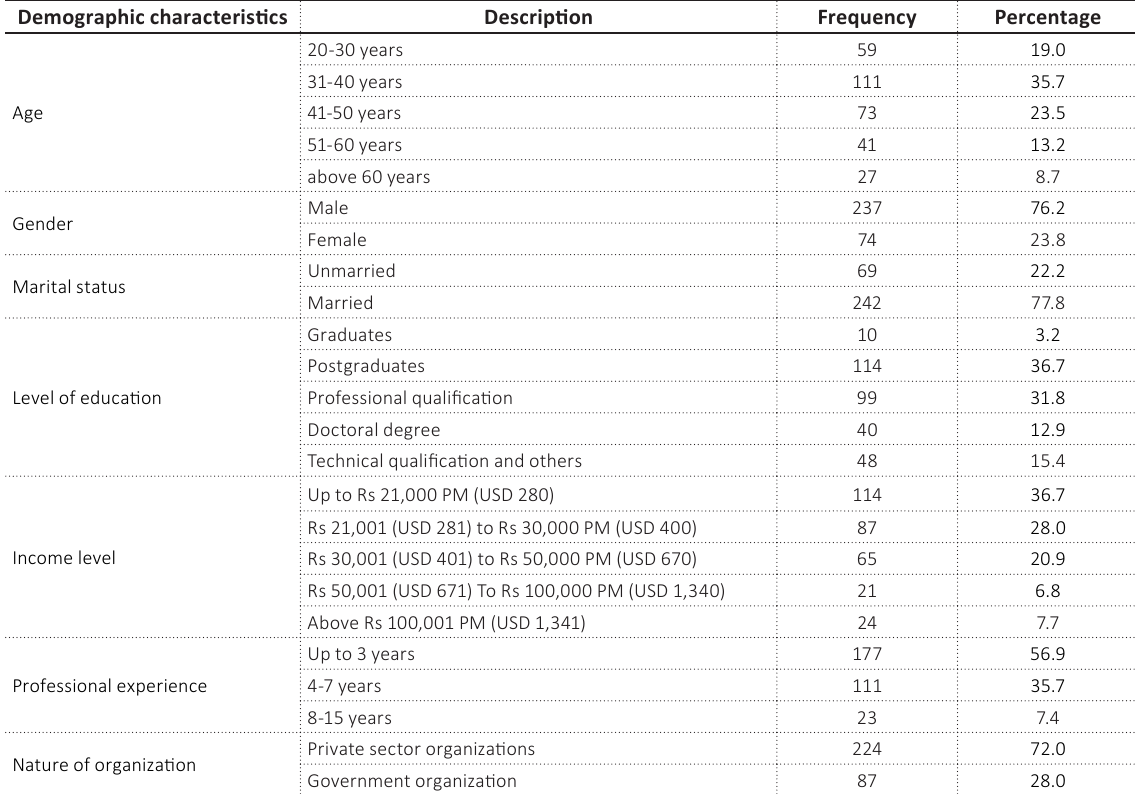
Table 1. Demographic characteristics of